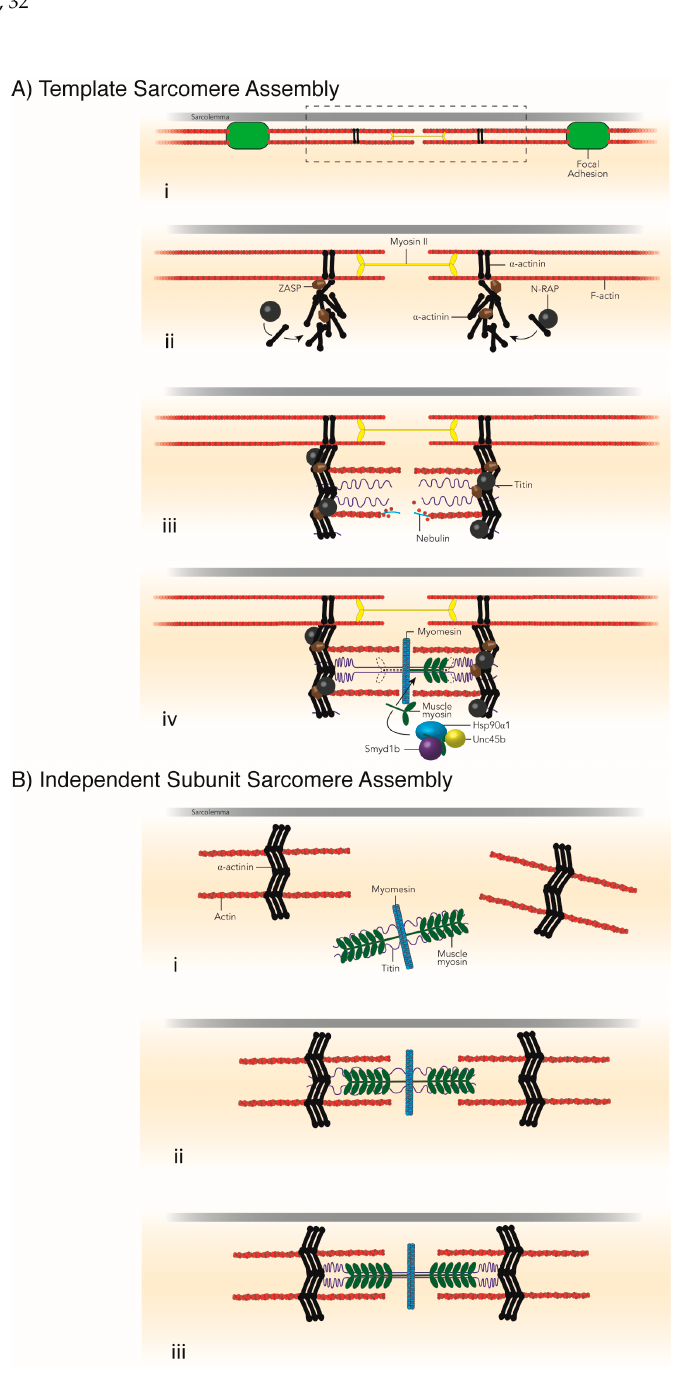
Figure 4. The Template and Independent Subunit Models of Sarcomere Assembly. The template model of sarcomere assembly suggests that sarcomeres require a template to form ( A ). The cell’s stress fibers, which have simple contractile structures, are proposed to be the templates for the formation of sarcomeres in myofibrils ( A , i ). Very similar to the premyofibril model, components of the Z-disc (such as α -actinin) form at stress fiber contractile sites ( A , ii ). Nebulin and titin extend from the Z-disc as actin is assembled into thin filaments along the nebulin scaffold ( A , iii ). Muscle myosin is folded and incorporated as thick filaments into the developing sarcomere by its chaperones and co-chaperones ( iv ). The independent subunit model for sarcomere assembly described sarcomere formation by the joining of pre-assembled subunits, or sections, of the sarcomere ( B ). These pre-assembled units consist of the Z-discs with attached actin thin filaments and the M-line combined with thick filaments and the protein giant, titin ( B , i – iii ). These units come together and physically connect at the sarcolemma to create the mature contractile sarcomere ( B , ii , iii ).